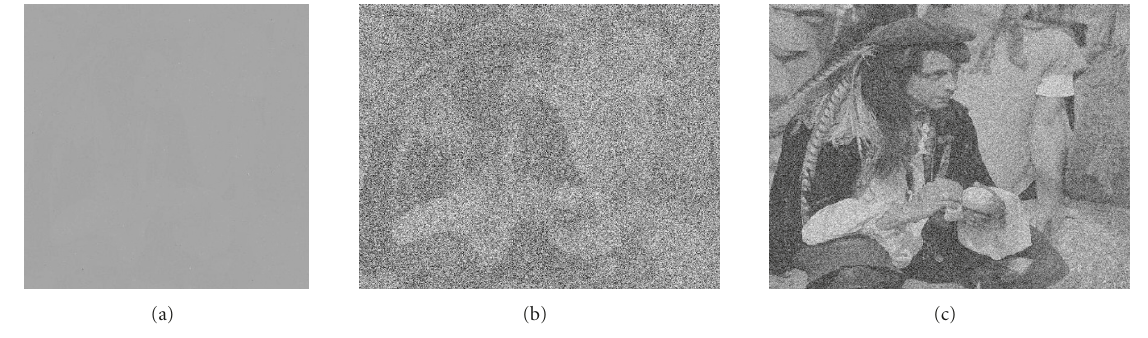
Figure 12: (a) Sample share; (b) decryption using t = 10 shares; (c) decryption using 40 shares.